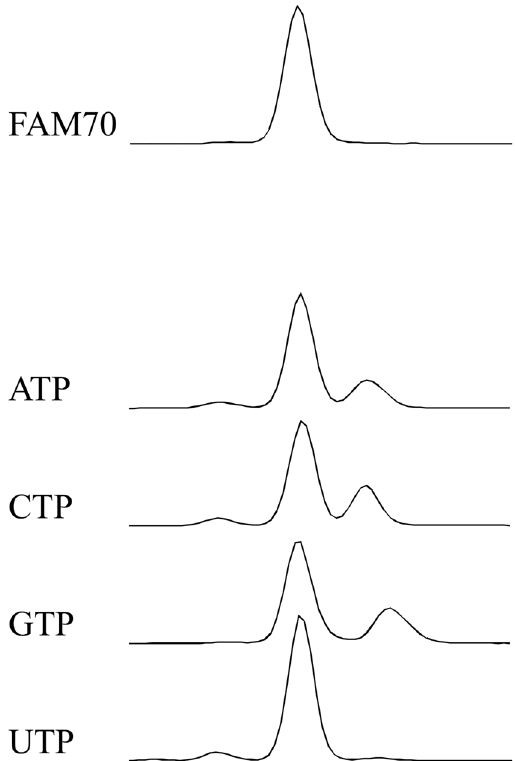
Figure 4. MMLV-RT utilizes ATP, CTP, GTP, and UTP as substrates. FAM70 DNA was incubated with MMLV-RT in the presence of 4 mM MnCl 2 and 2 mM ATP, CTP, GTP, or UTP for 10